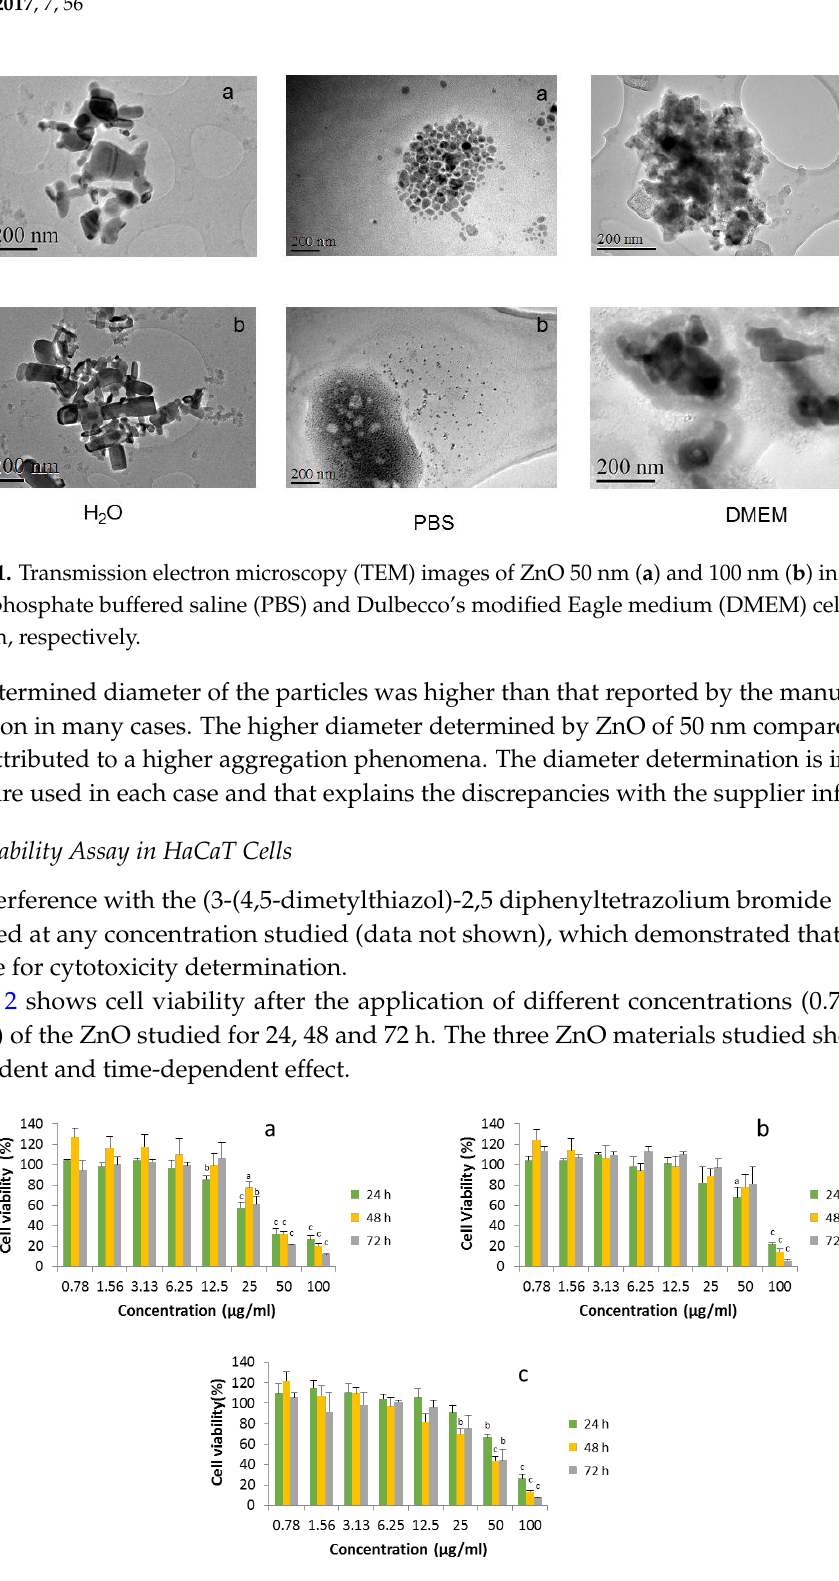
Figure 2. Cell viability of HaCaT cells exposed to different concentrations of ZnO ( a ) and ZnO 50 ( b ) and 100 nm ( c ), respectively, after 24, 48 and 72 h incubation. Mean values ± standard deviation of triplicates of at least three independent experiments. a p < 0.05, b p < 0.01 and c p < 0.001 compared to